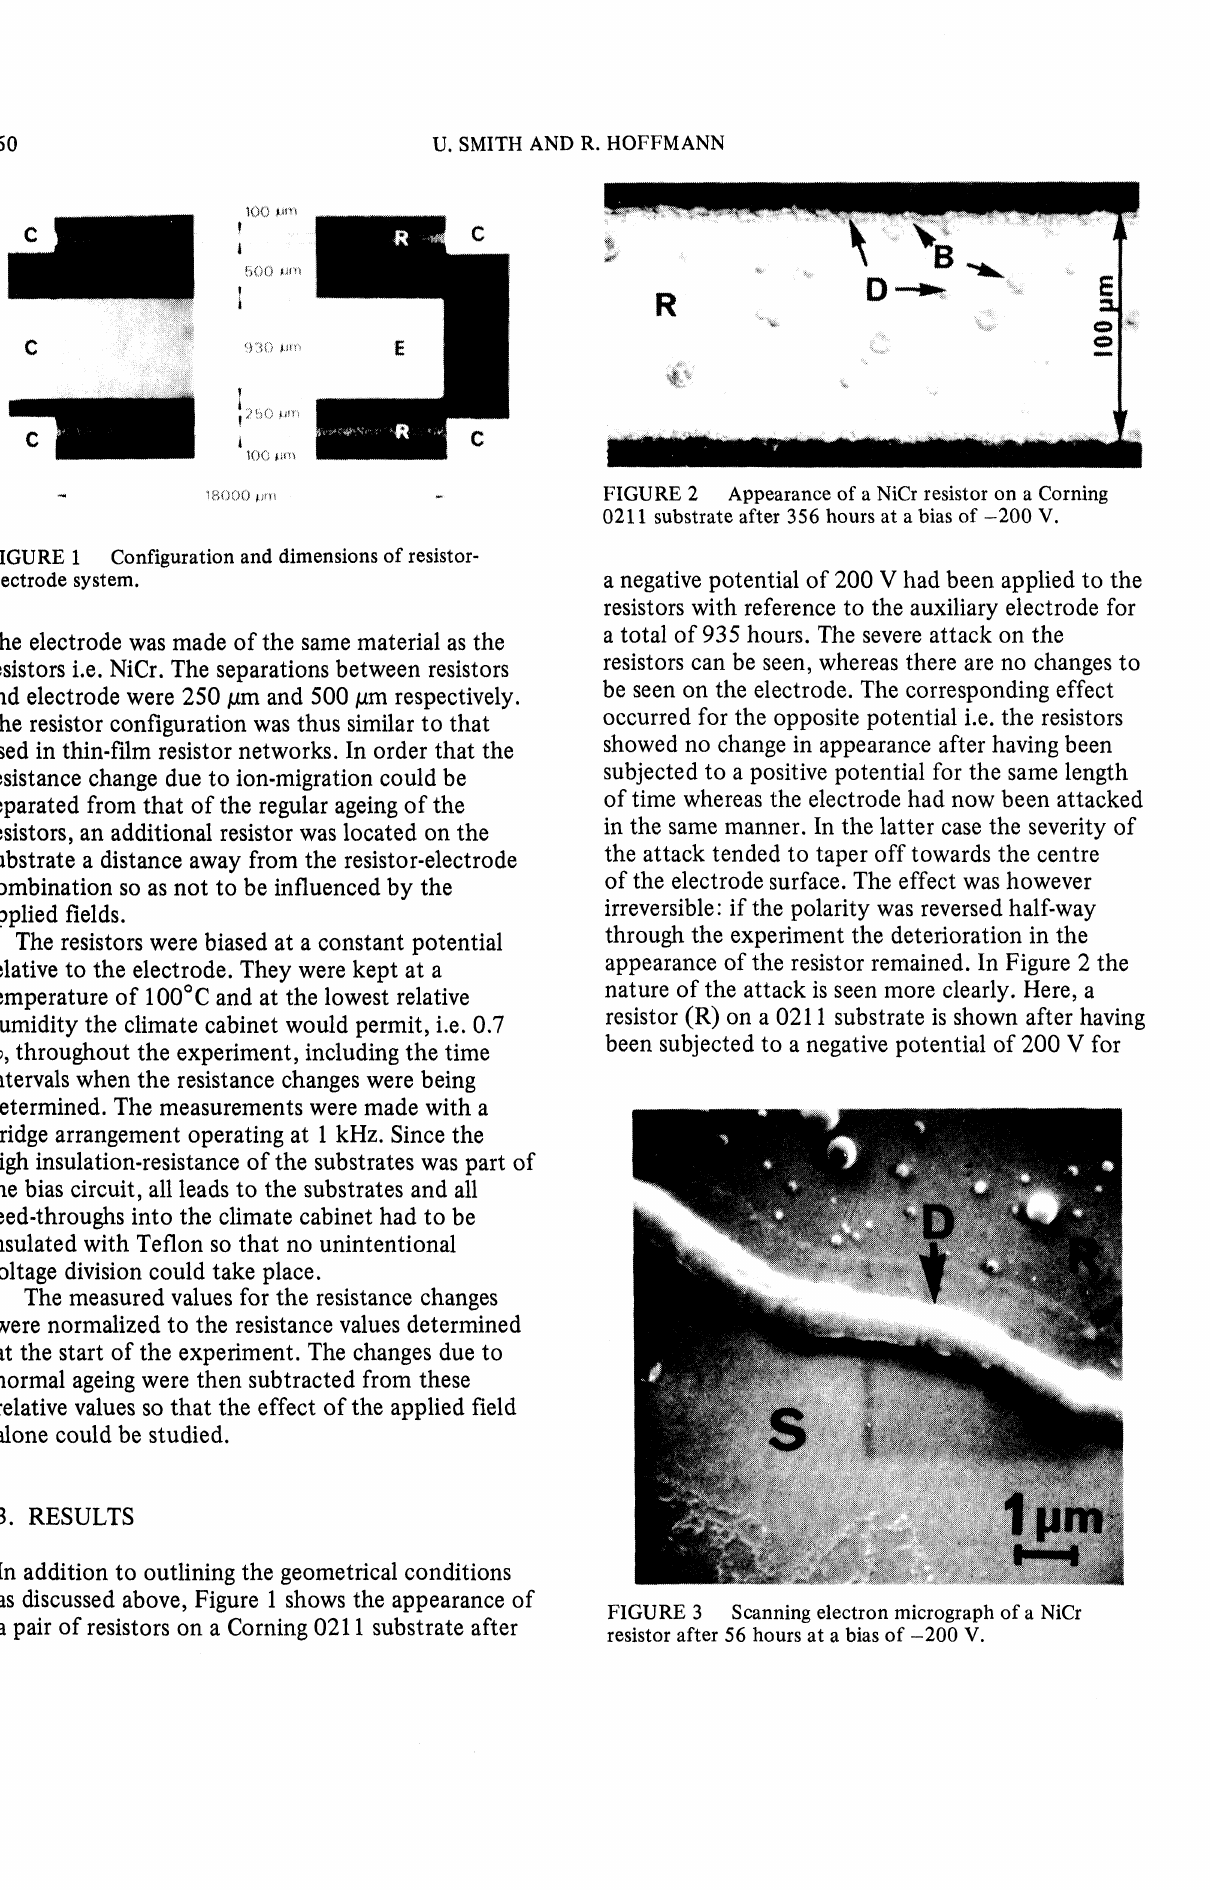
Appearance of a NiCr resistor on a Corning 0211 substrate after 356 hours at a bias of -200 V.